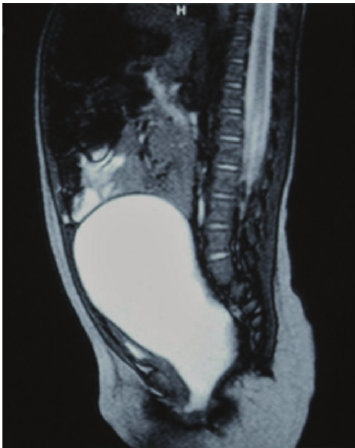
abdominal mass. The rest of the examination was normal.